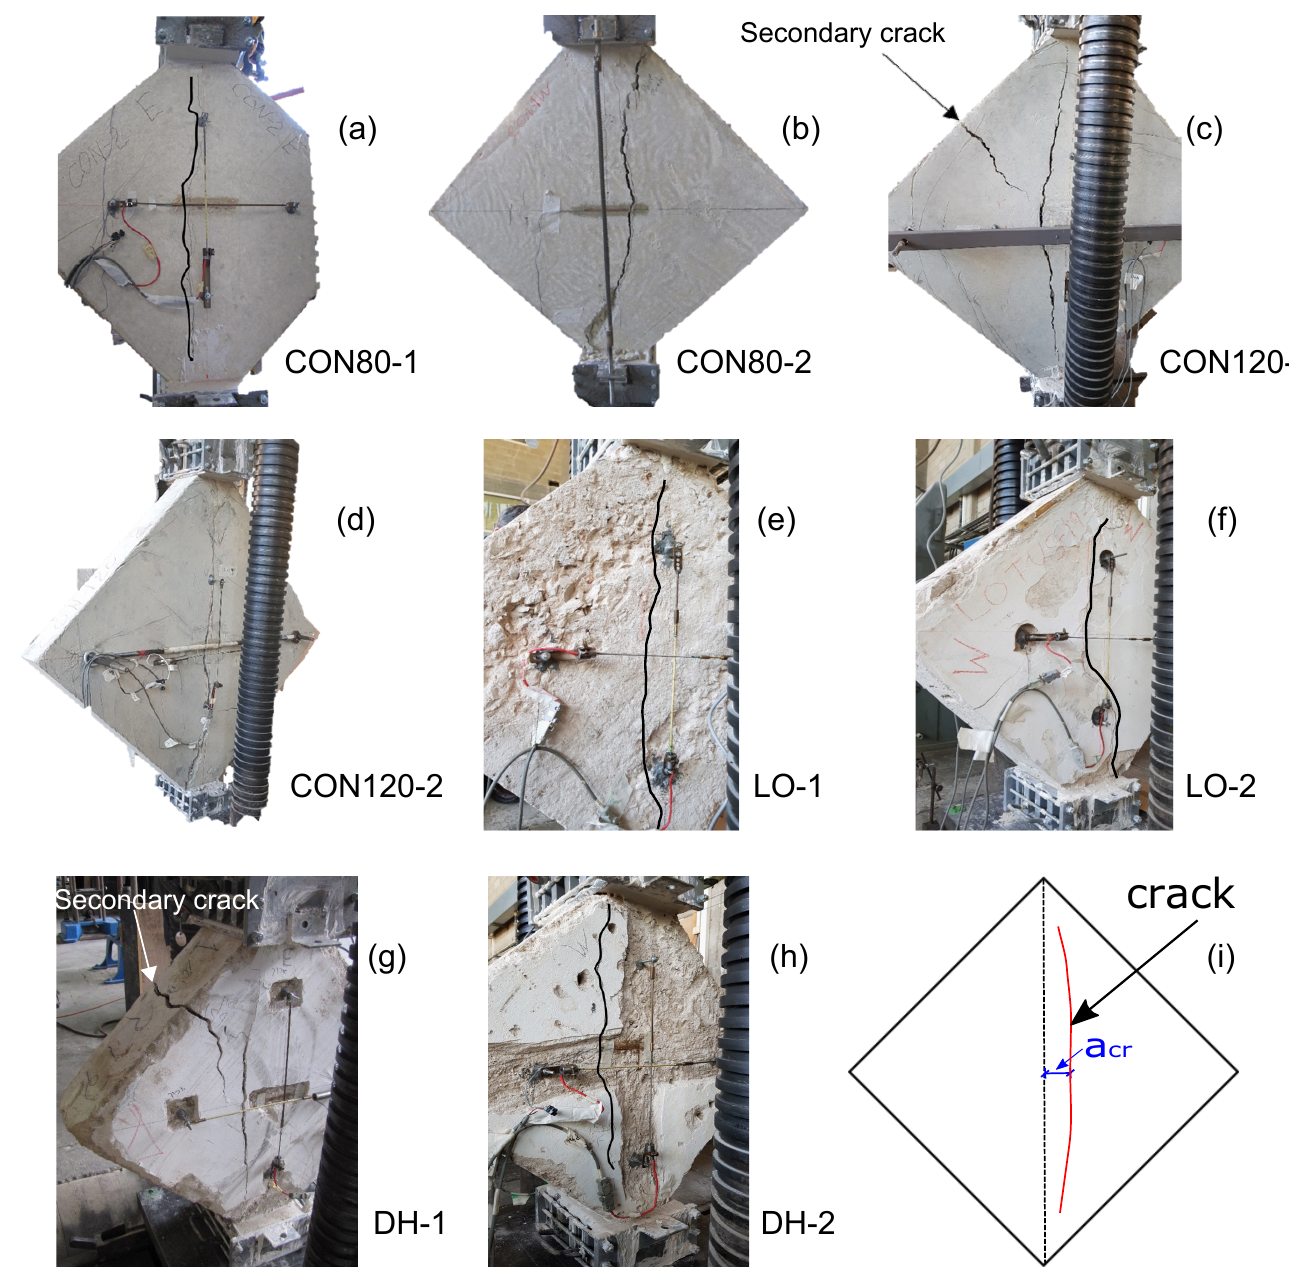
Figure 4. ( a – h ) Specimens after diagonal compression tests and ( i ) schematic location of the vertical